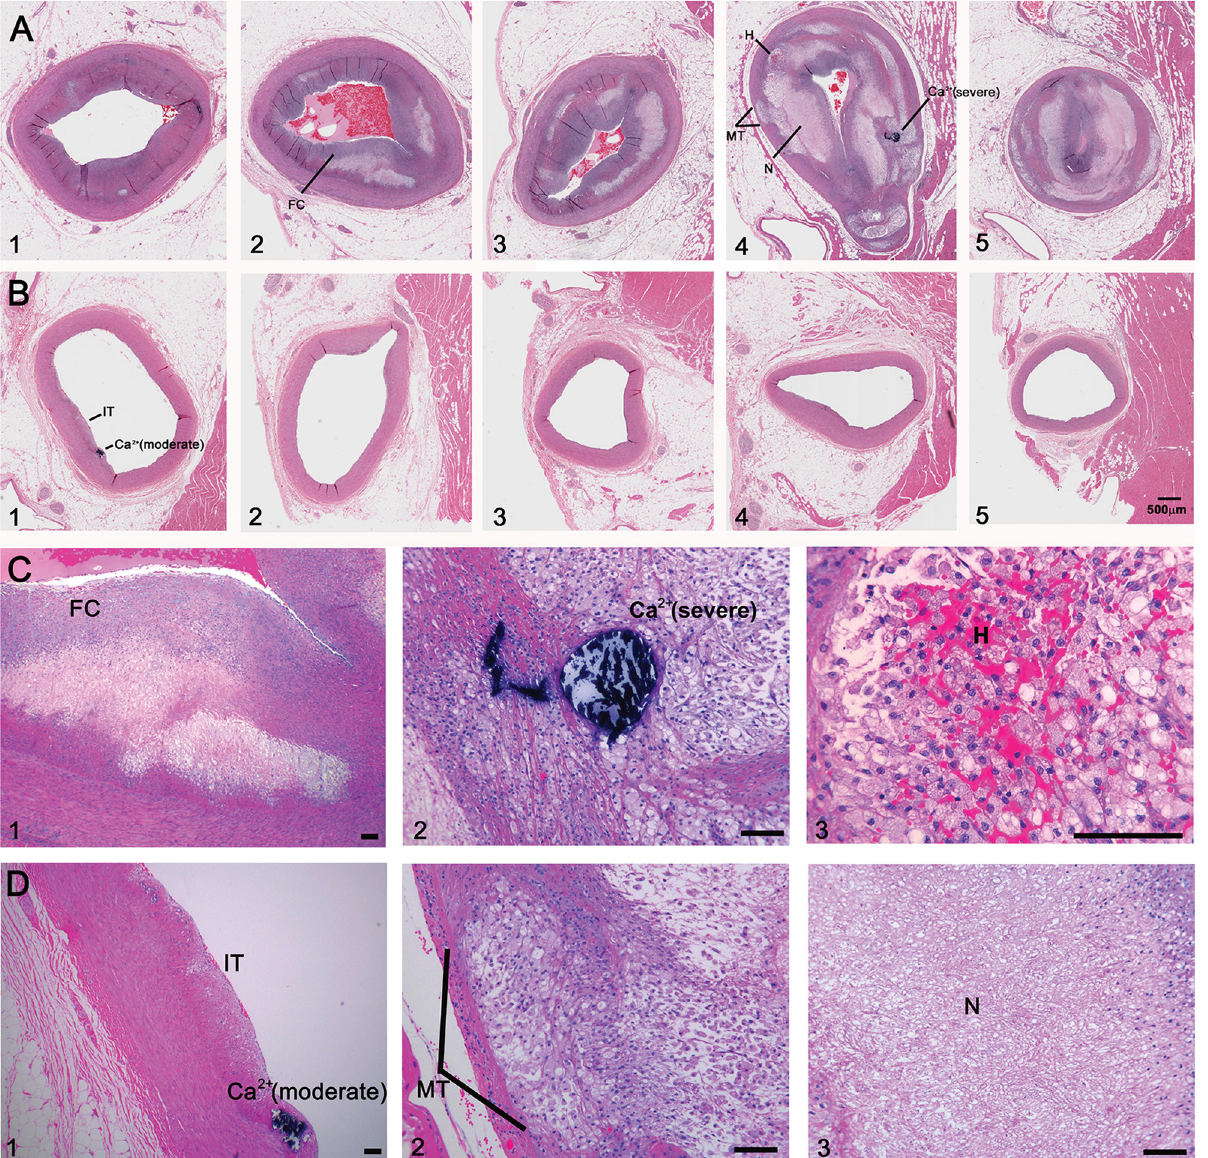
Fig 4. Coronary Artery Atherosclerosis in Insulin Resistant Pigs. Panels A1 to A5: Representative serial sections from the proximal to distal left anterior descending coronary artery are shown from an IR pig with severe and diffuse distal coronary atherosclerosis. The mean intimal area as a percent of medial area for all three coronary arteries for this pig was 203.6% proximally and 338.5% distally. Panels B1 to B5: In contrast, a pig with moderate coronary atherosclerosis had a mean intimal area as a percent of medial area for all three coronary arteries of 11.3% proximally and 5.8% distally. Features of coronary atherosclerosis in rows A and B are shown at higher magnification in rows C and D, respectively: intimal thickening (IT) and calcification in a pig with moderate atherosclerosis (Ca 2+ (moderate), Panels B1 and D1), calcification in a pig with severe atherosclerosis (Ca 2+ (severe), Panels A4 and C2), fibrous cap (FC, Panel A2 and C1), hemorrhage into the plaque (H, Panels A4 and C3), medial thinning (MT, Panels A4 and D2), necrosis (N, Panels A4 and D3). (Hematoxylin and Eosin, mag bar = 500 μ m is shown in B5 for rows A and B; mag bar = 10 μ m in all panels in rows C and D).